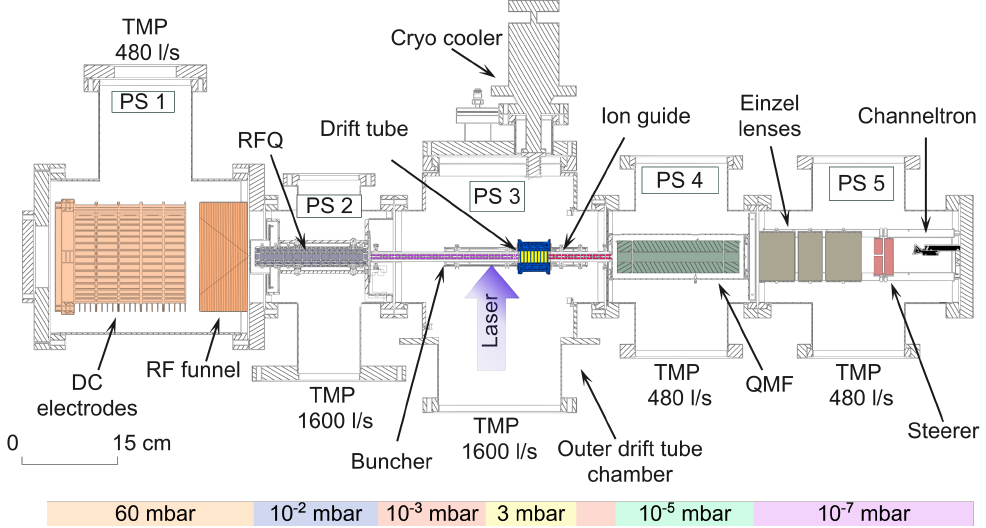
Figure 1. Schematic overview of the LRC apparatus. See text for more